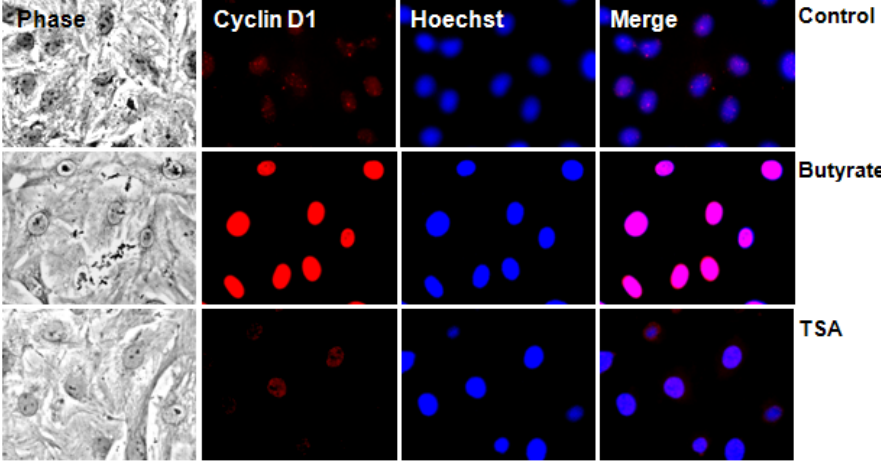
Figure 5. Intracellular localization of cyclin D1 in butyrate and TSA treated VSMC. VSMC treated with 5 mM butyrate or 0.5 µM TSA for 24 h were immunostained with cyclin D1 antibody followed by nuclear staining with Hoechst. Images of stained VSMC were captured using a Nikon fluorescence microscope with a CCD camera (400×